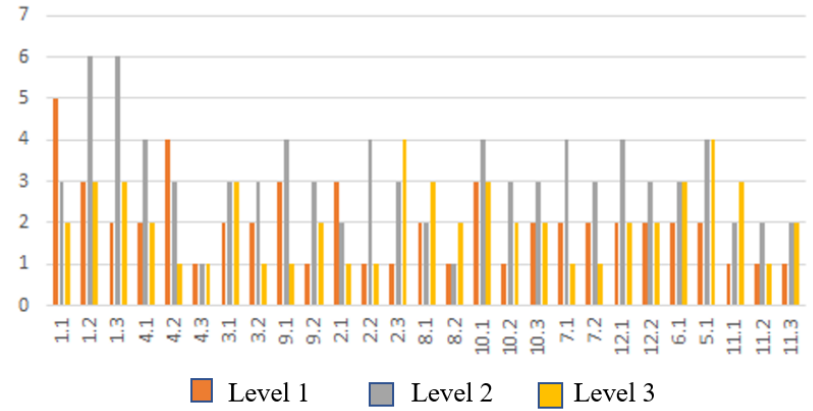
Fig. 4. Distribution of learning